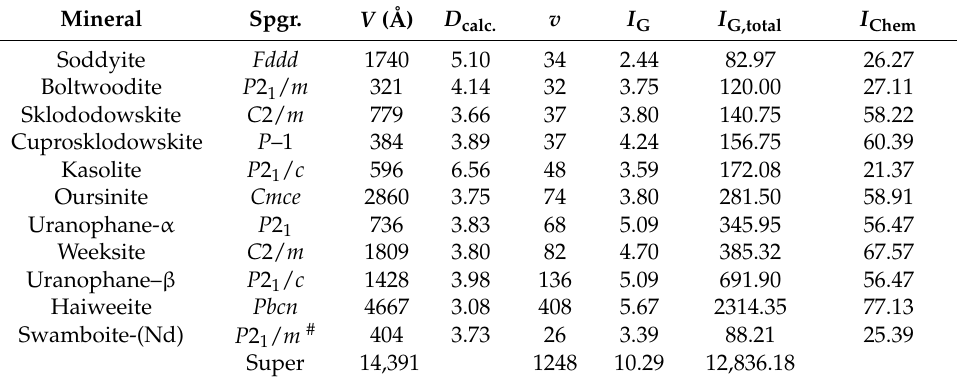
Spgr.—space group; v —the number of vertices in the corresponding quotient graph; I G —structural complexity contribution per atom (bits/atom); I G,total —structural complexity of the whole structure (bits/cell); I Chem —chemical information measures (bits/formula). # —average structure; Super—superstructure, space-group P 2 1 / m ( a 1, b 1, g 1)00(– a 1, b 1, g 1)00( a 2, 0, g 2)0 s